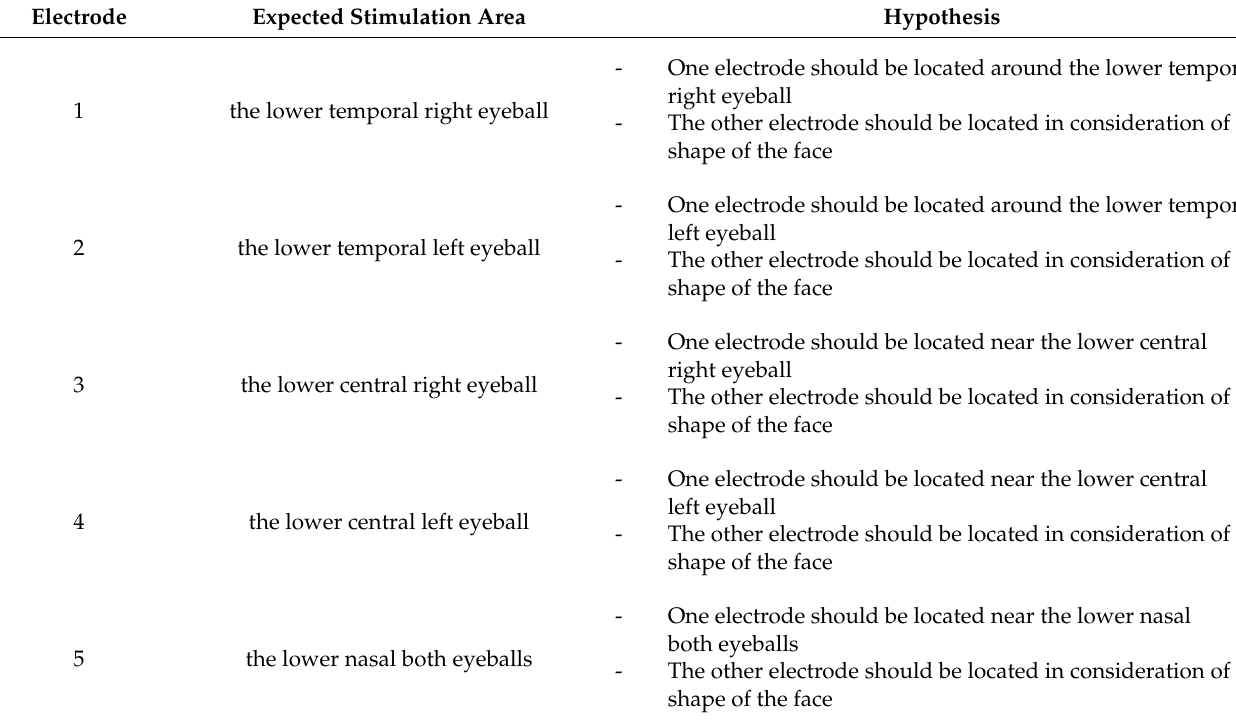
Table 3. Summary of the hypotheses for each